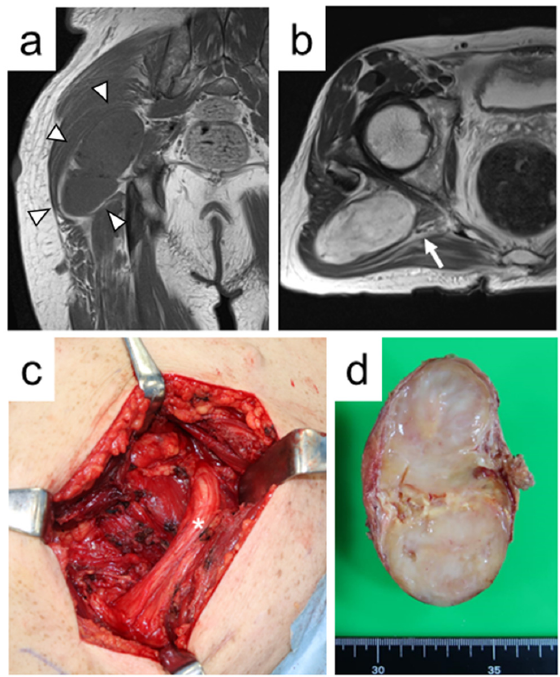
Figure 1. A 55 ‐ year ‐ old male with nodular plexiform neurofibroma of the right buttock (Case 7). ( a ) Coronal T1 ‐ weighted magnetic resonance image shows an intramuscular tumor with homogeneous iso ‐ signal intensity compared with skeletal muscle (arrowheads). ( b ) Axial T2 ‐ weighted magnetic res ‐ onance image reveals that the tumor between the piriformis muscle and gluteus maximus muscle is adjacent to the sciatic nerve (arrow). ( c ) An intraoperative photograph shows that the tumor originated from the branch of the sciatic nerve (asterisk) to the gluteus maximus muscle and was treated with en bloc resection. ( d ) The en bloc resected specimen reveals a yellowish ‐ white tumor on gross finding (Tumor 10).